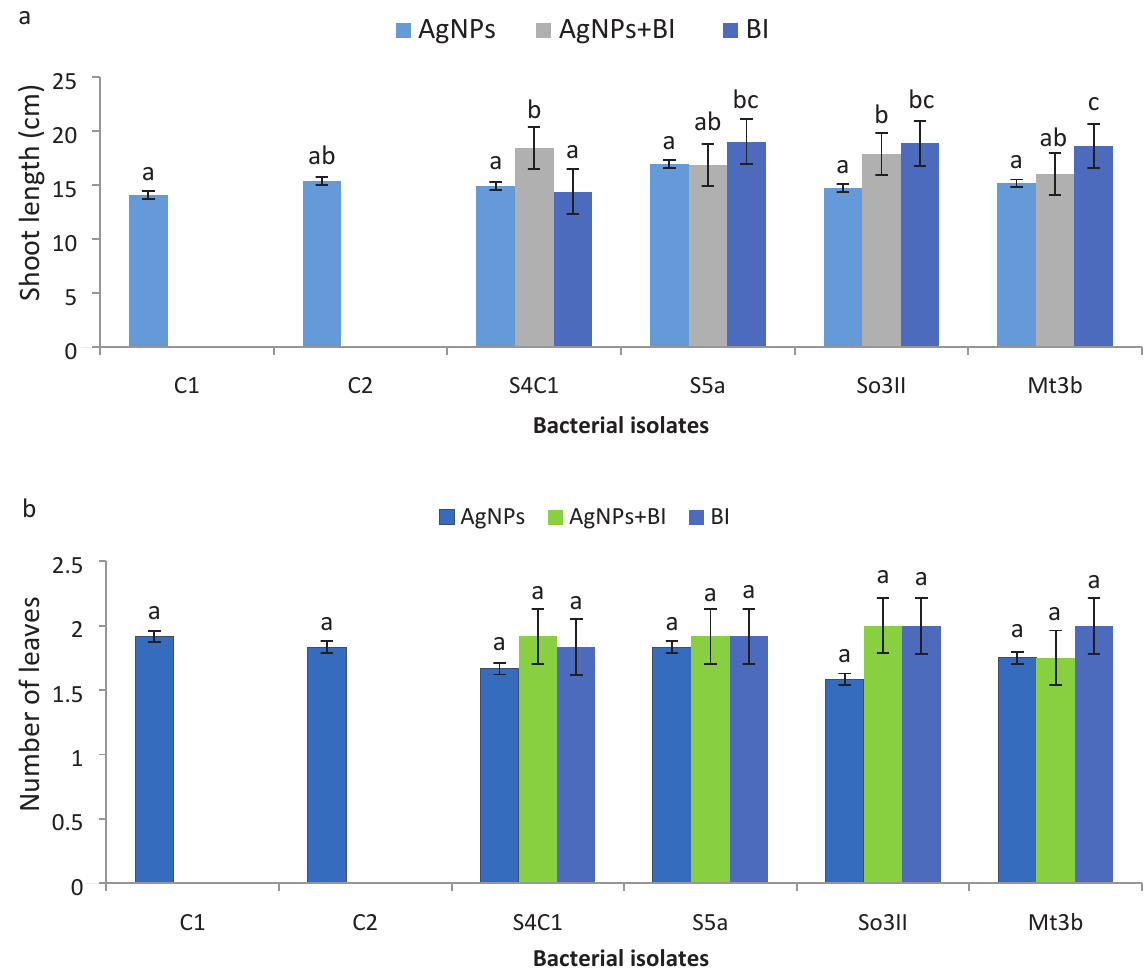
Figure 4: (a) Shoot length (cm); (b) Number of leaves after inoculation treatment T1 (bacterial AgNPs). T2 – bacterial AgNPs+BI; T3 – BI; C1 – Control treatment using water; C2 – Control treatment using AgNO3. Different letters indicate significant difference between treatments using Duncan’s multiple range test (P =